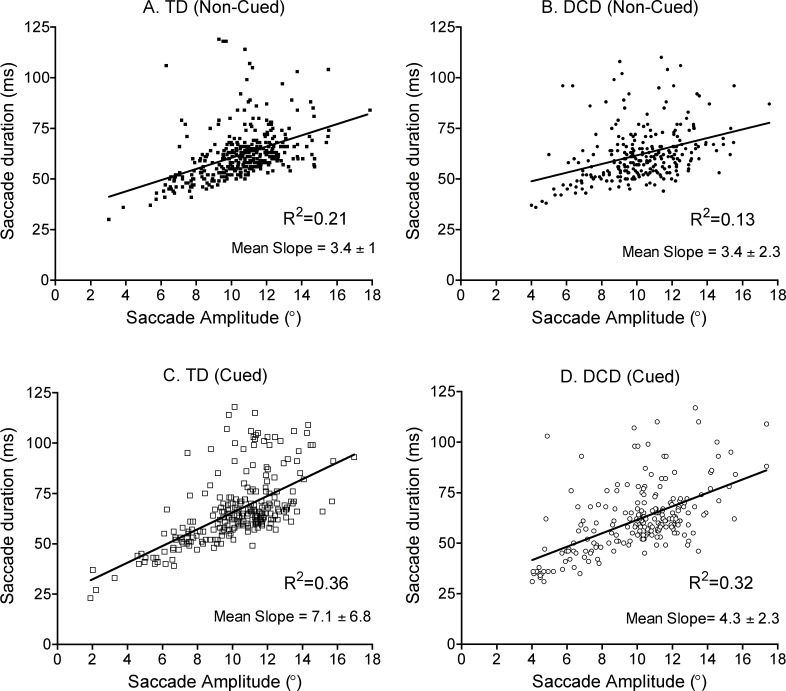
The reported data are for all saccades made within the trial that exceeded 2° in amplitude during the eye only (EO) task.Saccade duration and amplitude (main sequence) of TD children (A and C, left) and children with DCD (B and C, right) during Non-Cued (A and B, top graphs) and Cued (C and D, lower graphs) conditions. The graph shows the relationship between the saccade’s duration and corresponding amplitude. These included anticipatory saccades from the Cued conditions as these occurred in more than 50% of trials in the DCD group. All graphs show significant R2 values, which reveal a linear relationship between these saccade parameters in both groups and show the mean slopes obtained from each participant’s main sequence. Comparisons between group and condition did not reveal significant differences.